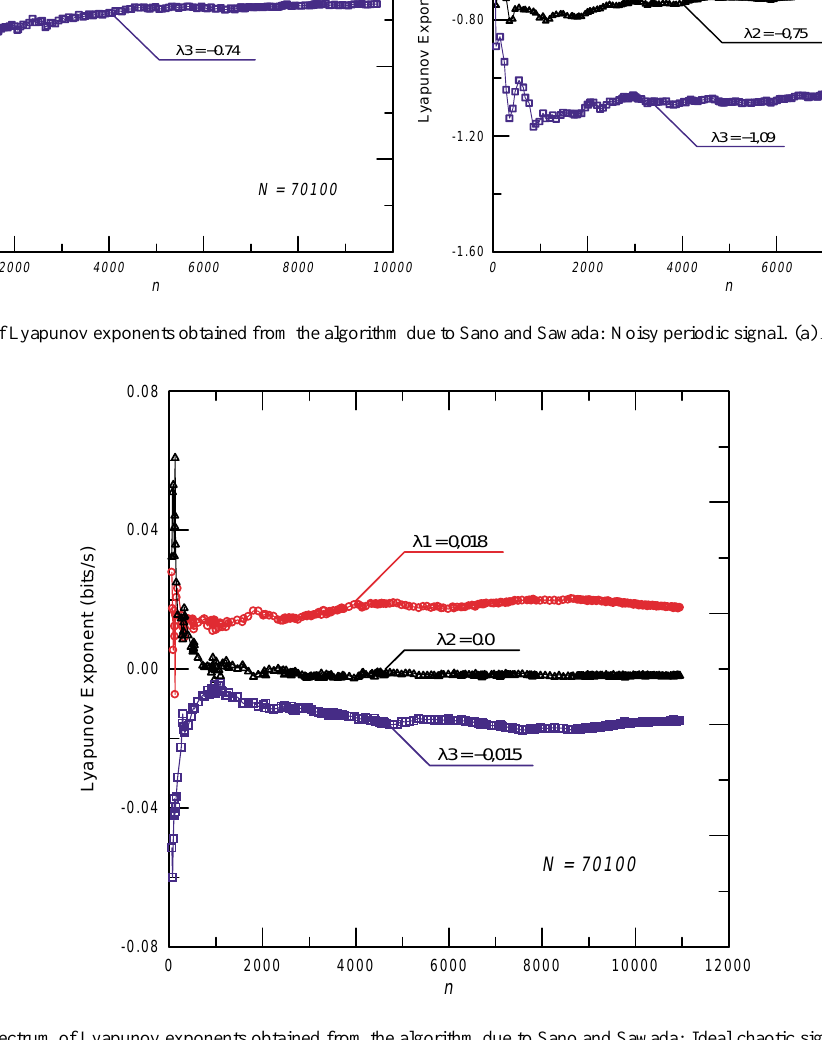
Fig. 14. Spectrum of Lyapunov exponents obtained from the algorithm due to Sano and Sawada: Ideal chaotic signal ( A = 0 ). Hence, Lyapunov exponents can be computed